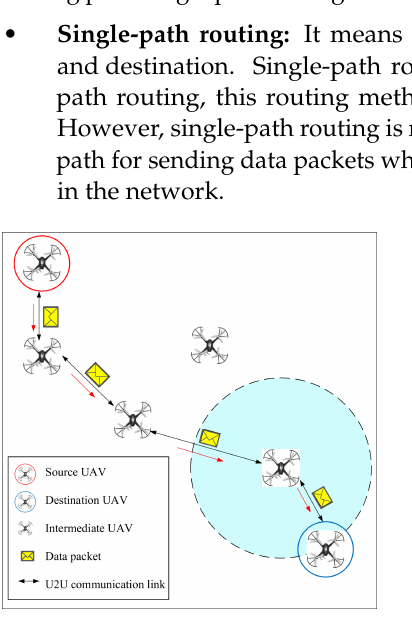
Figure 13. Single-path